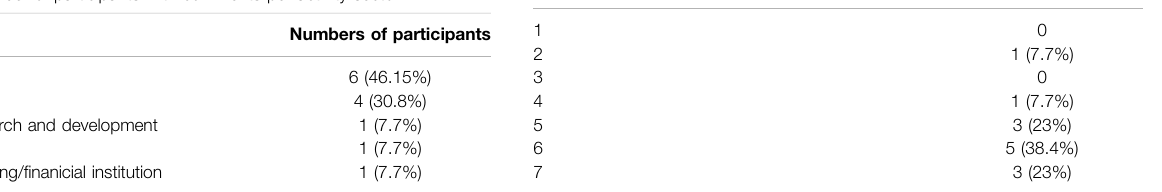
TABLE 6 | Number of participants with comments per activity sector.